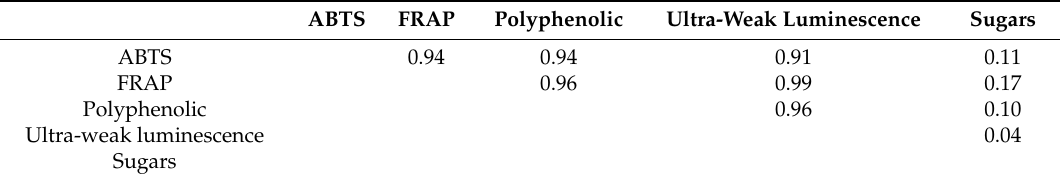
Table 6. Correlation between antioxidant activity and polyphenol content, ultra-weak luminescence, and